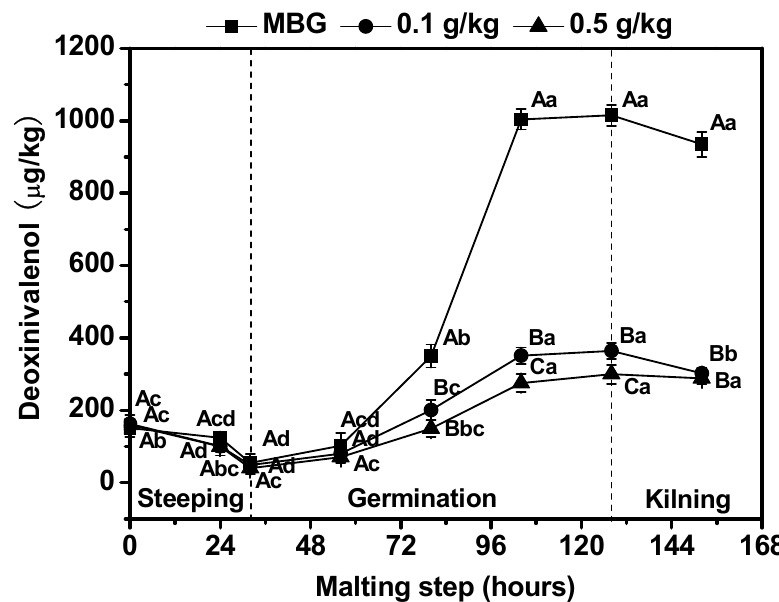
Figure 3. Effects of chitosan on deoxynivalenol (DON) content on barley during malting. Each number represents the mean ± standard deviation of three replicates. Within the same malting time and among different treatment conditions, different capital letter superscripts indicate significant differences ( p <0.05); within the same treatment condition and among different malting times, different lowercase superscripts indicate significant differences ( p <0.05).